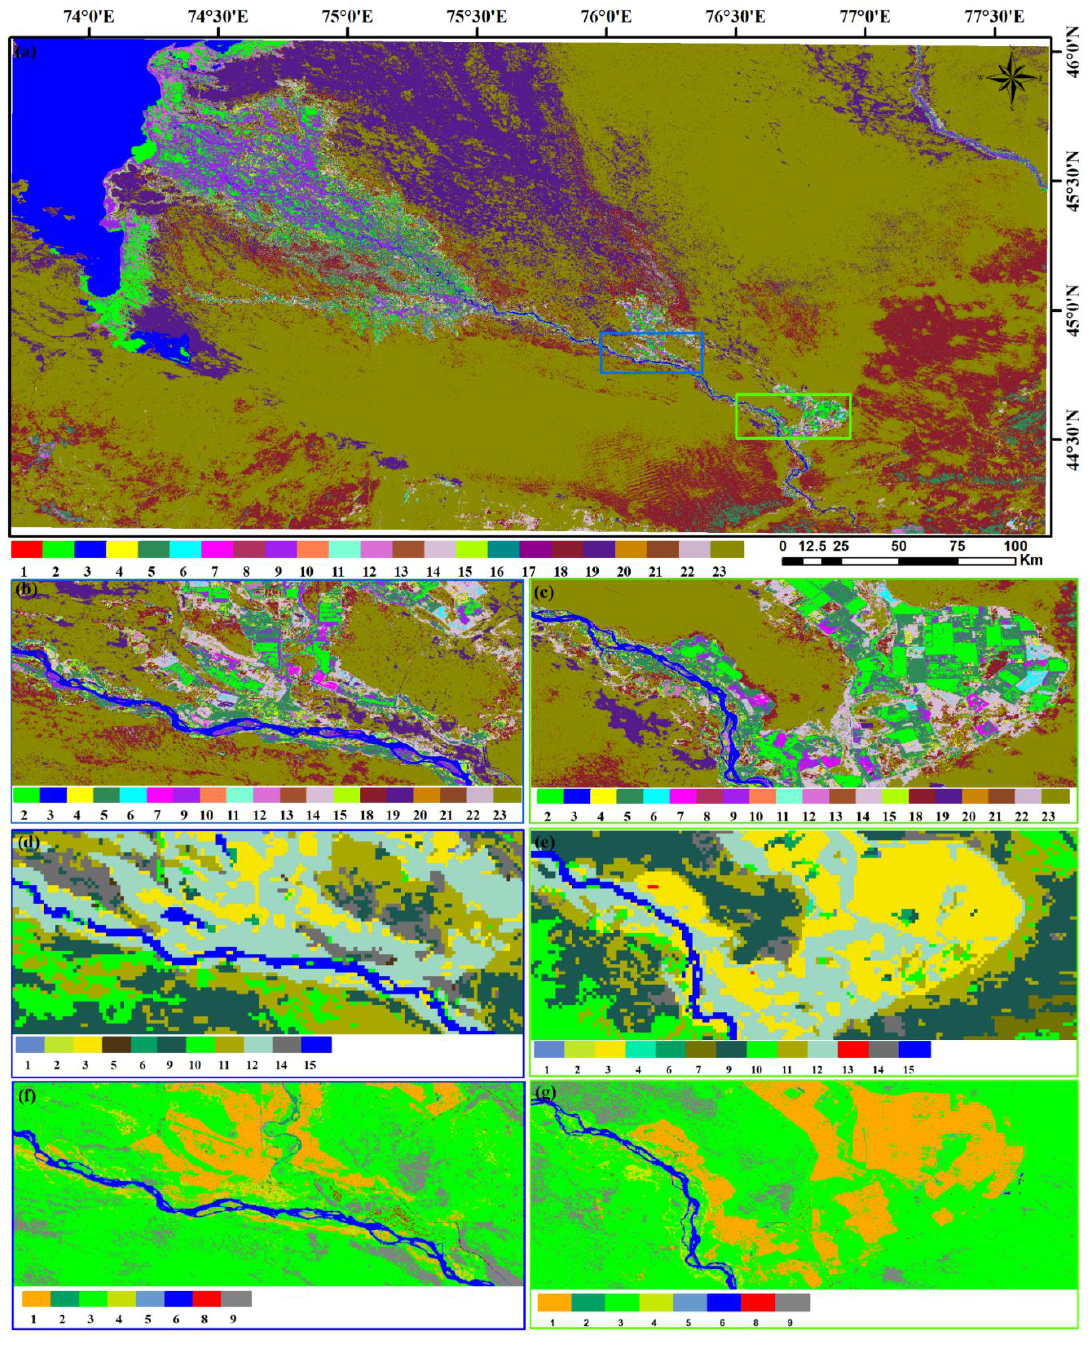
Figure 10. Final vegetation distribution map using Sentinel-2 MSIL1C products with the END-ERDT classifier for our study area ( a ) and subareas ( b , c ) and corresponding examples from the 2015 MODIS LUCC products ( d , e ) and the 2017 GLC30 ( f , g ) products (for the legends, refer to that in Figure 1).